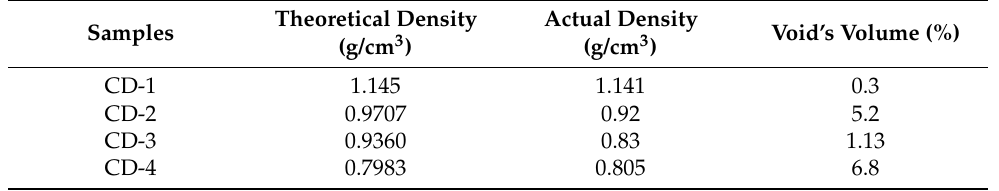
Table 4. Density and void content (%) of developed composites. Actual density by ASTM C693.